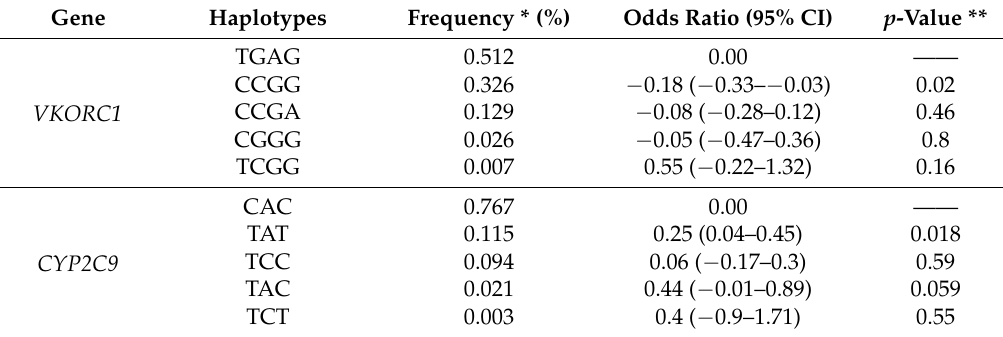
Table 6. Frequencies of the haplotypes of VKORC1 and CYP2C9 genes among the 212 warfarin responsiveness